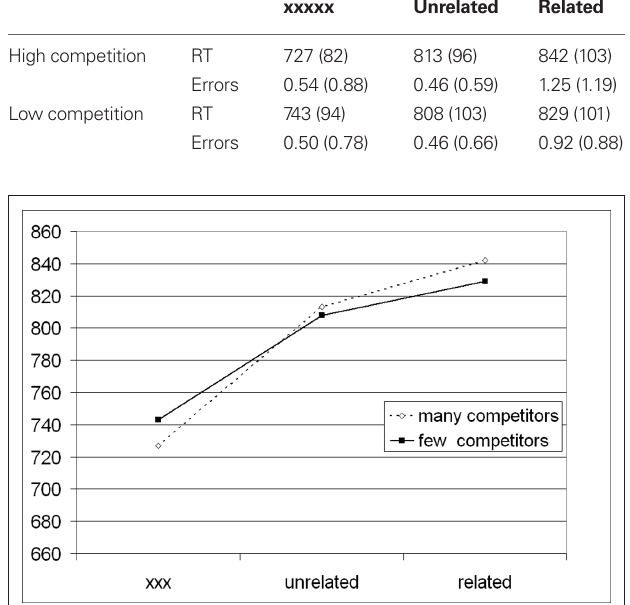
FigurE 1 | Mean naming latencies across conditions (in ms).